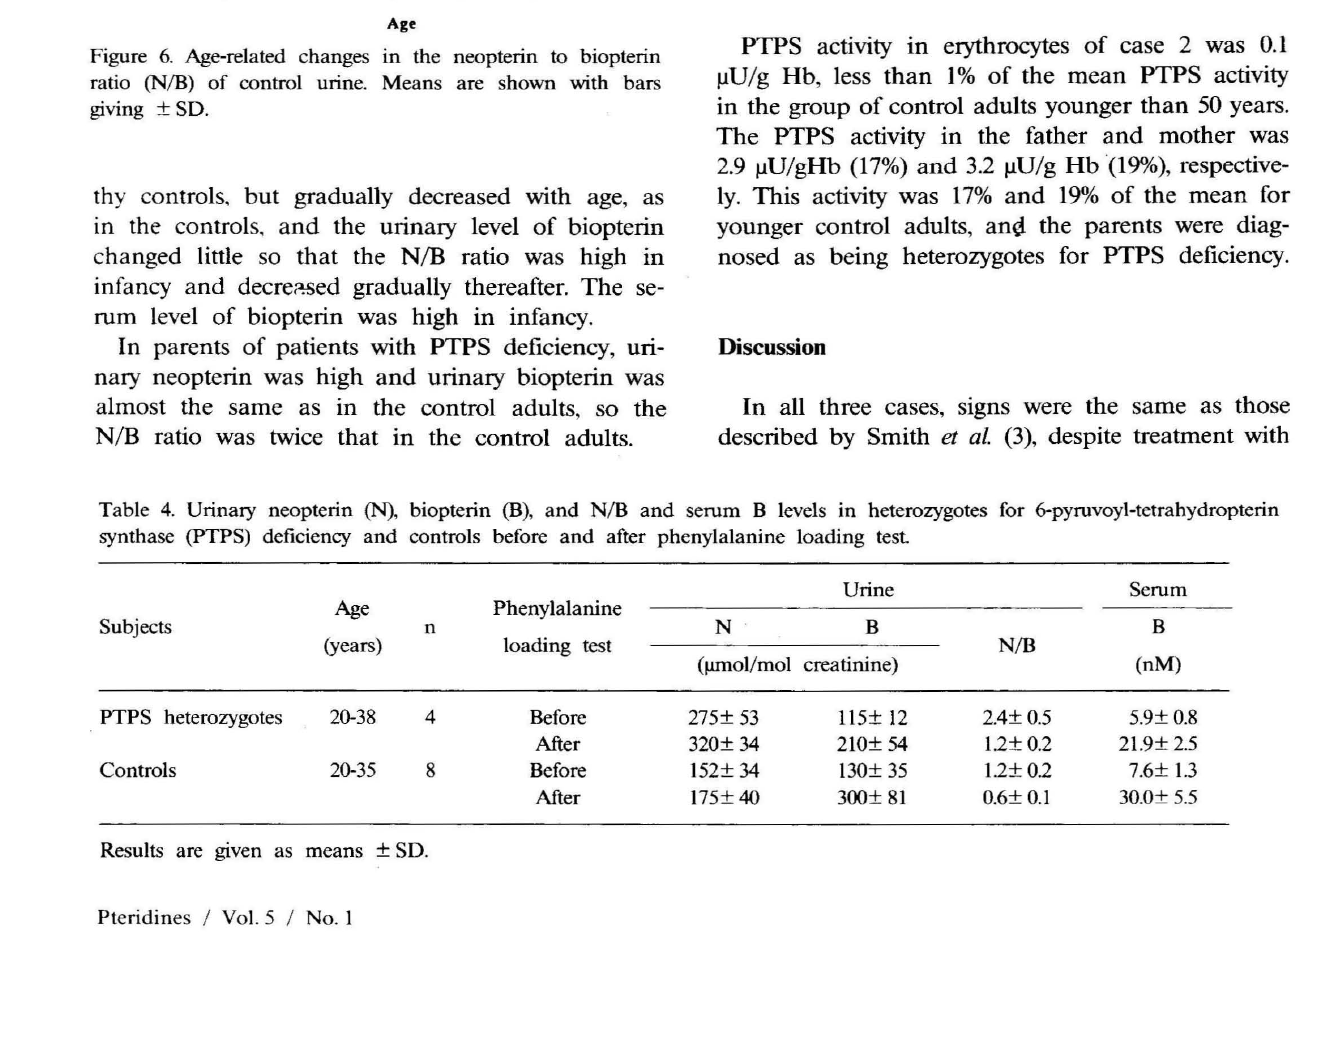
Figure 6. Age-related changes in the neopterin to biopterin ratio (NIB) of control urine. Means are shown with bars giving ± SD.